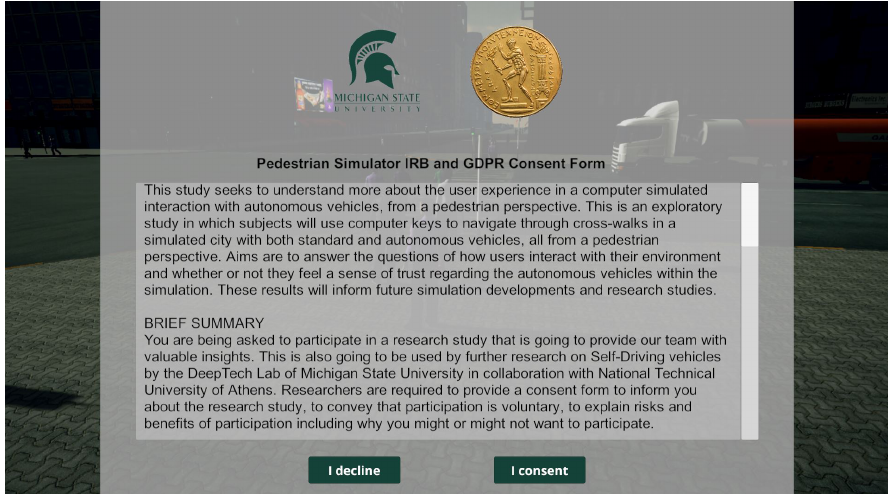
Figure 7. The consent form informs the users about the terms of use of the